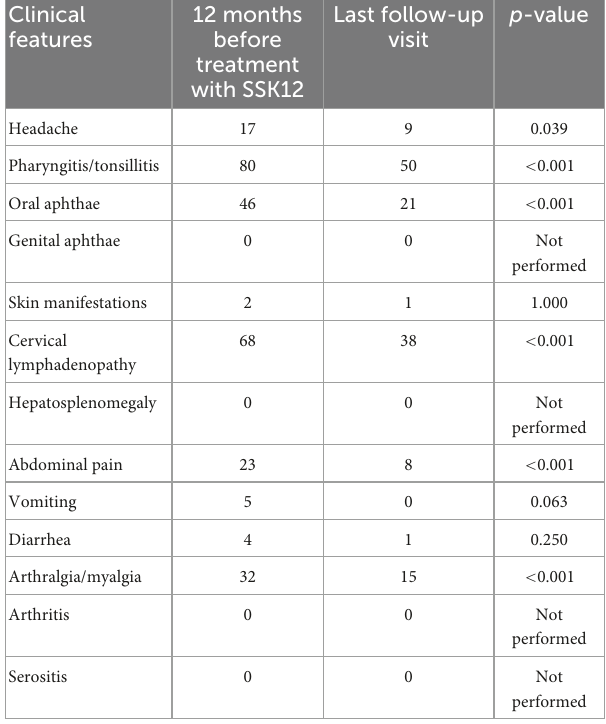
TABLE 2 Clinical features of patients with PFAPA syndrome recruited from the AIDA International Registry in the 12-month period prior to SSK12 initiation and at the last follow-up